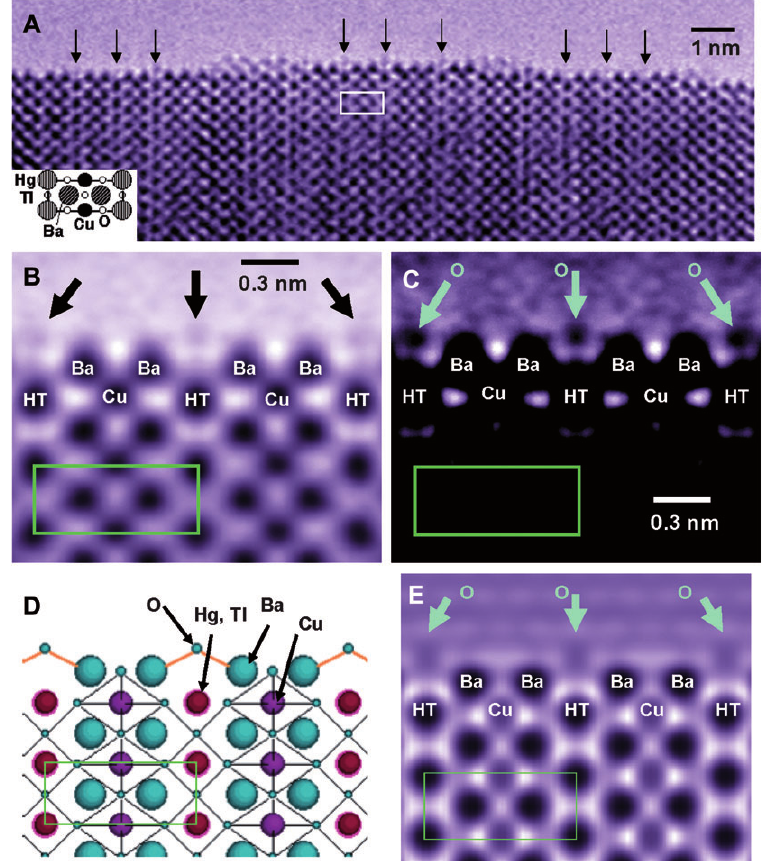
Figure 7 (A) HREM image of Hg cates the Hg and Tl atoms. (C) Image depth of 200 – 255 gray scale. (D) Surface structure model of Hg simulated HREM